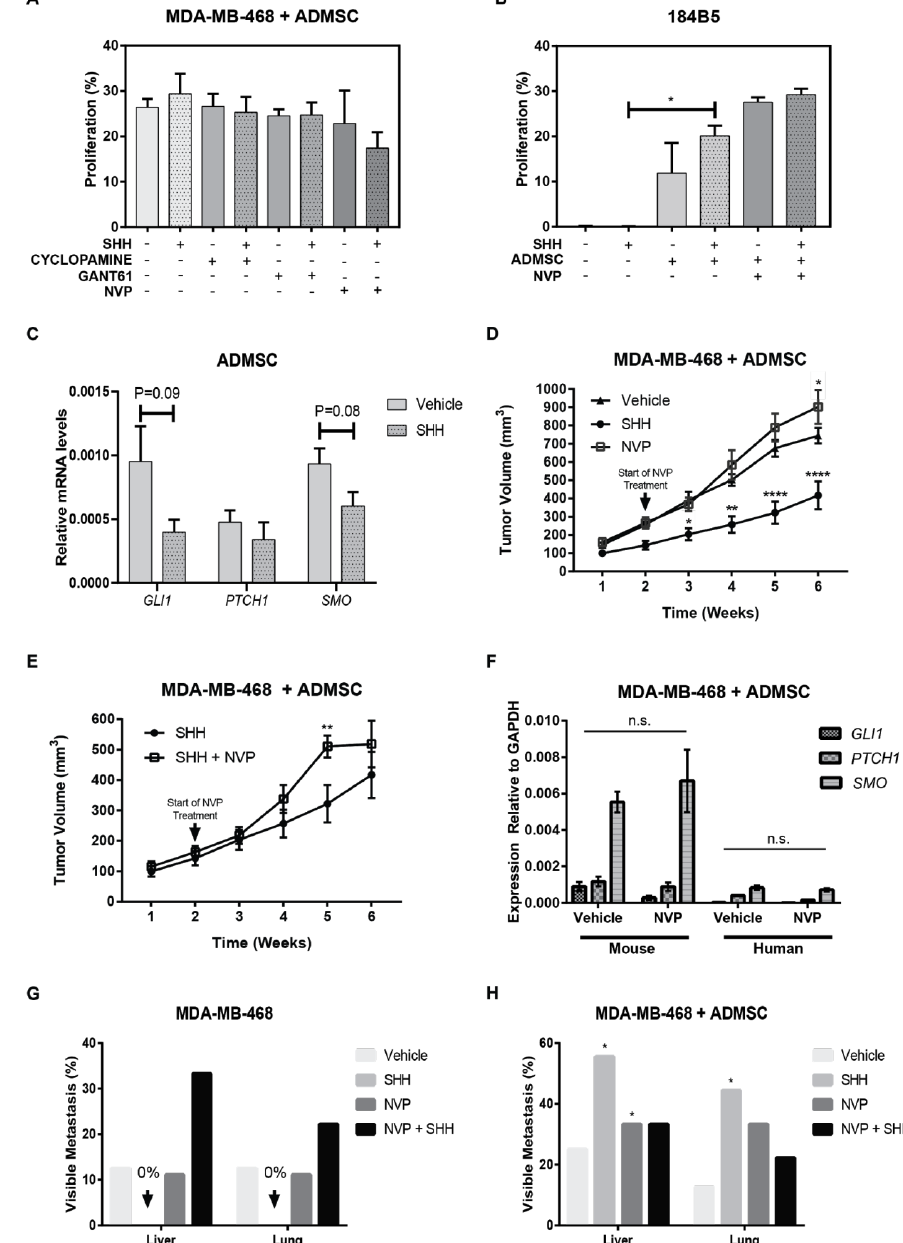
Figure 6. Mesenchymal cells modulate the effect of Hedgehog (Hh) signaling. ( A , B ) Proliferation analysis of 5-ethynyl-2’-deoxyuridine (EdU)+ MDA-MB-468 and 184B5 cells co-cultured with adipose mesenchymal stem cells (ADMSC) treated with Sonic hedgehog (SHH)-ligand and Hh inhibitors for 96 h. Significance was determined via Student’s t -test, * p < 0.05. ( C ) Expression levels of glioma associated oncogene family zinc finger 1 ( GLI1 ), patched1 ( PTCH1 ) and Smoothened ( SMO ) genes relative to GAPDH at 24 h post-treatment. ( D , E ) Tumor growth curves in xenografted tumors composed by MDA-MB-468 + ADMSC +/ − SHH-ligand. Daily dosage with NVP or Vehicle during the last four weeks. Data show the average mean +/ − SEM of nine mice per treatment. Significance was determined via ANOVA analysis comparing Vehicle (D) or SHH (E) with NVP, * p < 0.05, ** p < 0.01, **** p < 0.0001. F ) Expression levels of GLI1 , PTCH1 , and SMO relative to GAPDH in xenografted tumors using human and mouse-specific primers. Data represent mean +/ − SEM of six mice per condition. No significant di ff erences were observed by Student’s t -test. ( G , H ) Percentage of mice with visible metastases. Significance was determined by Fisher’s exact test, * p <